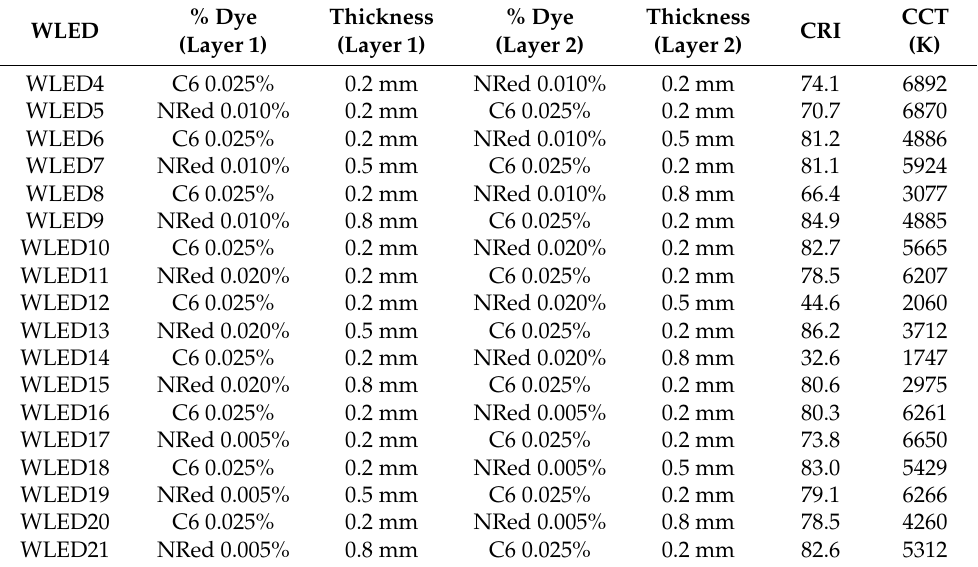
Table 2. A summary of WLEDs devices (4 to 21) along with their optical properties.